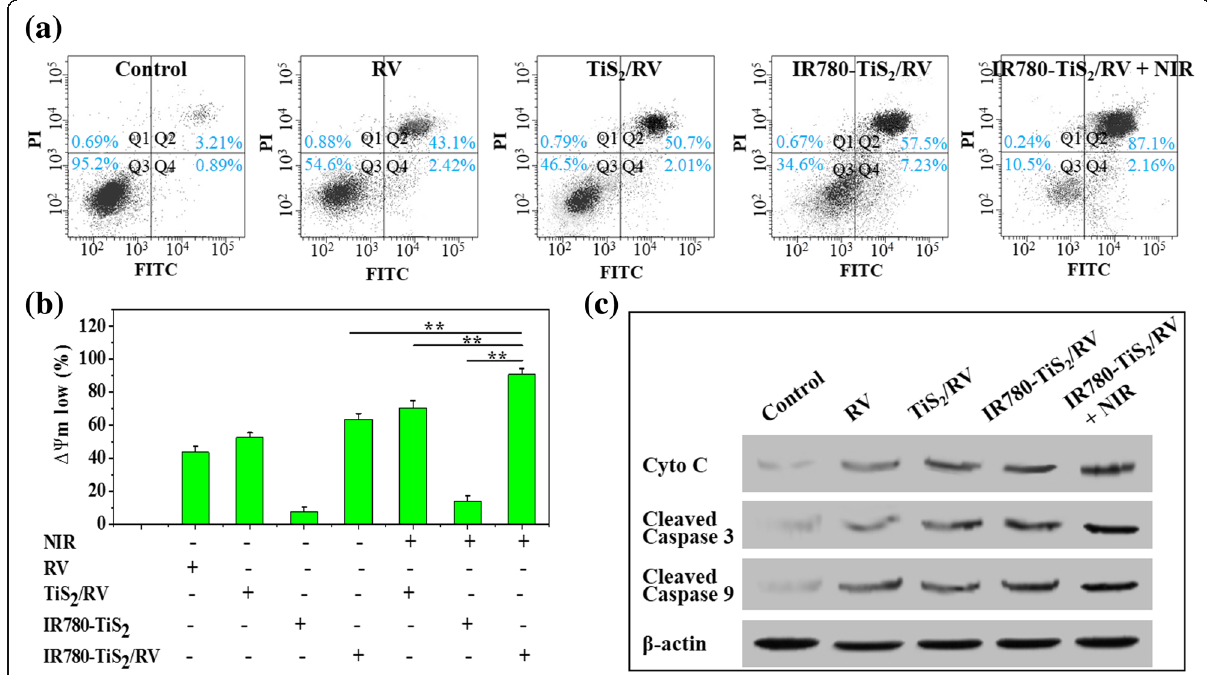
Fig. 5 a Cell apoptosis of CT26 cells treated with PBS (control), RV, TiS 2 /RV, IR780-TiS 2 /RV, and IR780-TiS 2 /RV + NIR by FCM. b The change in mitochondrial membrane potential of CT26 cells treated with PBS (control), RV, TiS 2 /RV, IR780-TiS 2 /RV, and IR780-TiS 2 /RV with or without NIR irradiation by FCM. c Expression of apoptosis-related proteins in CT26 cells treated with PBS (control), RV, TiS 2 /RV, IR780-TiS 2 /RV, and IR780-TiS 2 / RV + NIR. Cytochrome c, cleaved caspase-3, and cleaved caspase-9 were tested by Western blot. **P < 0.01, compared with IR780-TiS 2 /RV, TiS 2 / RV + NIR, and IR780-TiS 2